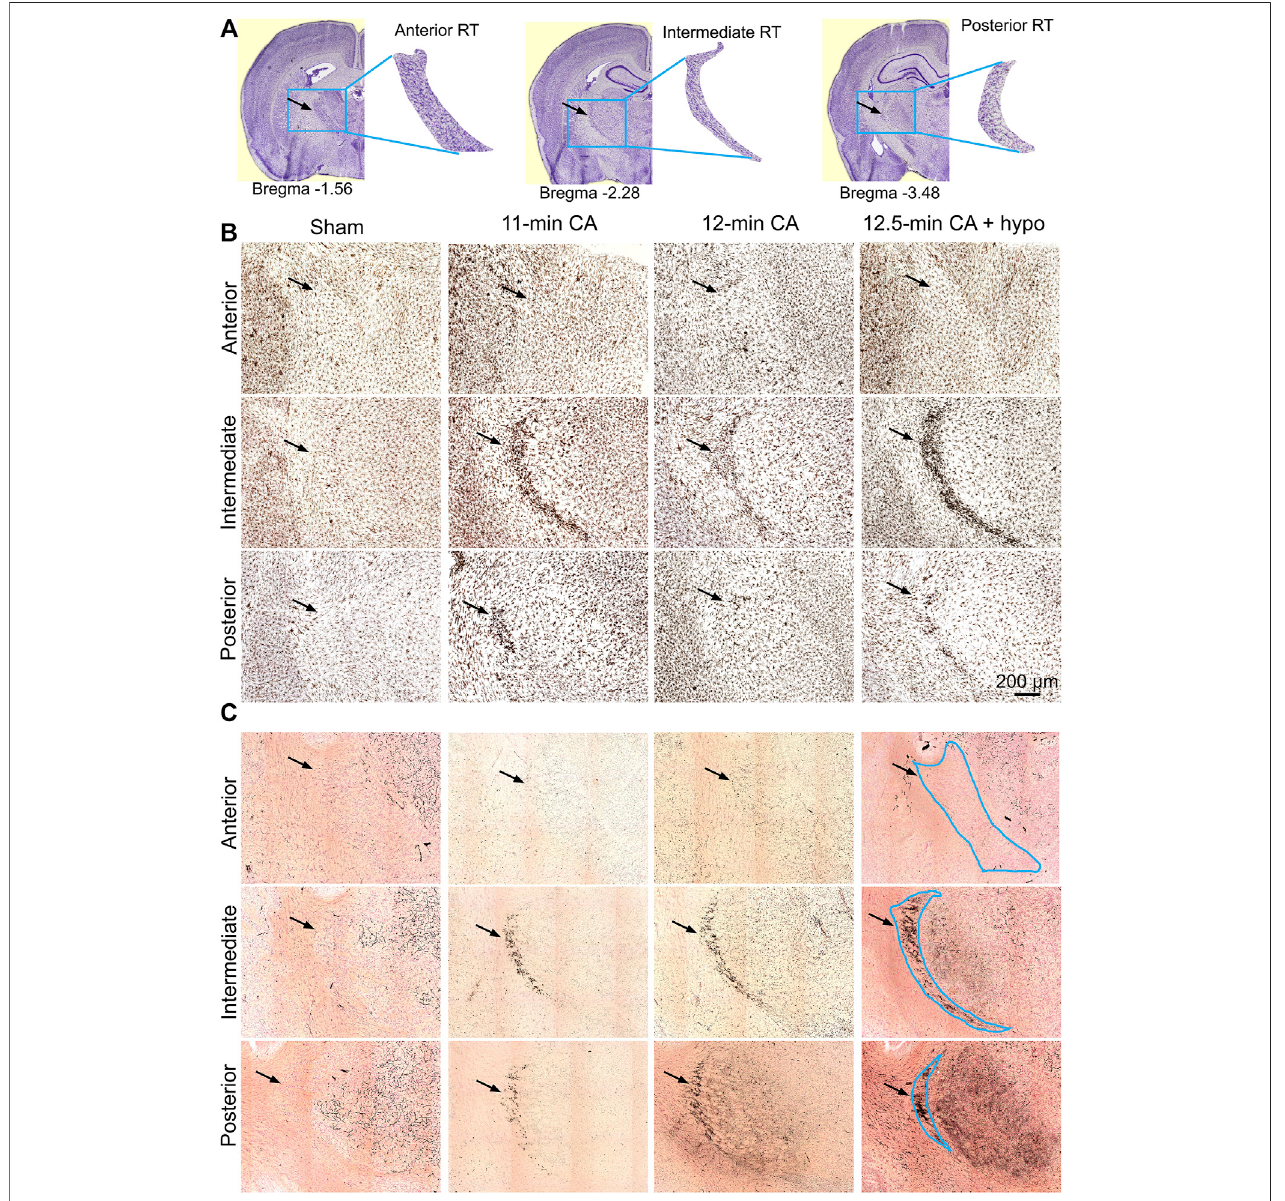
FIGURE 4 | CA-induced microglia activation and neurodegeneration are observed in the posterior and intermediate but not in the anterior RT (A) Schematic identi fi cation of anteroposterior position and shape indicated with respect to bregma. The blue box (2000 μ m × 1,600 μ m) indicates the captured RT segments; the blackarrowheadsindicatethelocationofROI (B,C) CompositionofthreeIba1-stained (B) andCuAg-stained (C) coronalsectionsthroughtheanterior,intermediateand posterior of RT from each of the sham; 11 min, 12 min, and 12.5 min + hypothermia CA groups. Scale bar represents 200 µm applied for all images.